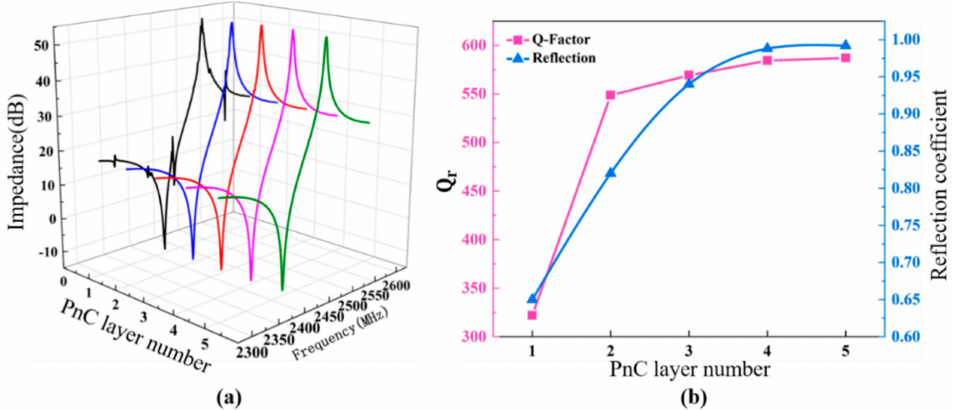
Figure 10. Impedance spectrum of the PhC-FBAR based on a triangular lattice PhC with different numbers of PhC layers ( a ), and the corresponding acoustic reflection coefficient of the PhC and Q r of the PhC-FBAR at the resonance frequency ( b